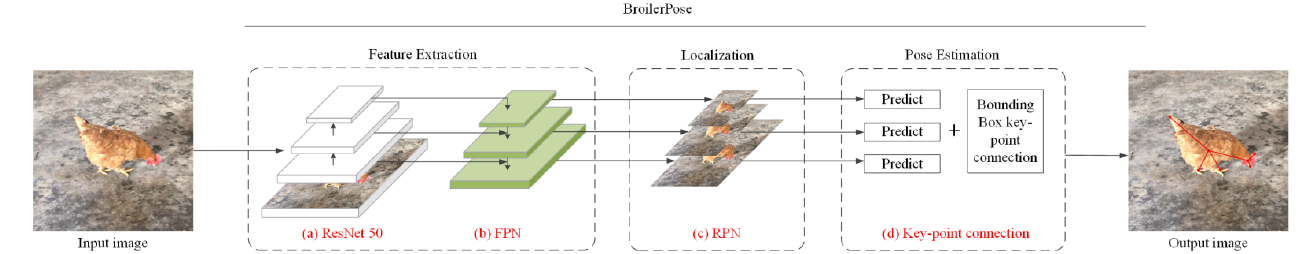
Figure 4. BroilerPose pose-estimation algorithm architecture: ( a ) The pre-trained ResNet-50; ( b ) FPN architecture, which includes a classify and a regression network; ( c ) RPN; ( d ) Key-point connection, output the broiler’s posture.